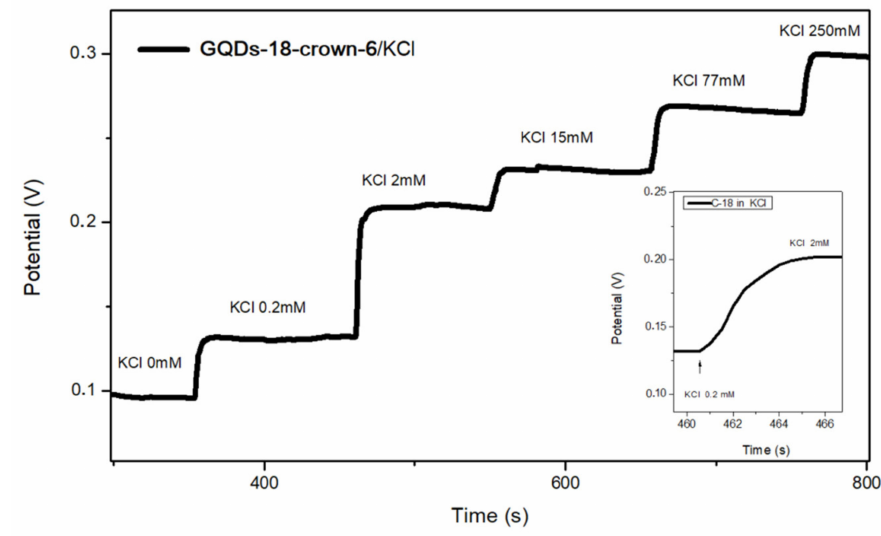
Figure 3. Potentiometric tests of GQDs-18-crown-6/SPCE towards K + ions with different concen- trations. In the inset is shown an enlargement of the step leading from 0.2 to 2 mM in the metal ions